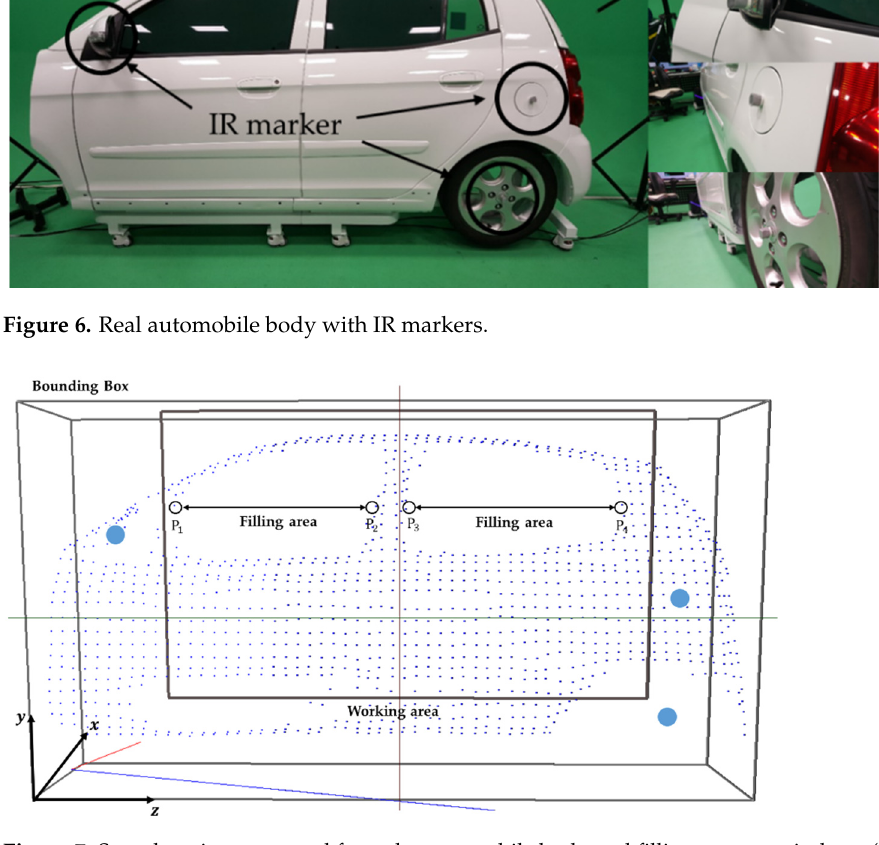
Figure 7. Sample points extracted from the automobile body and filling area on windows (cyan circle: IR markers).